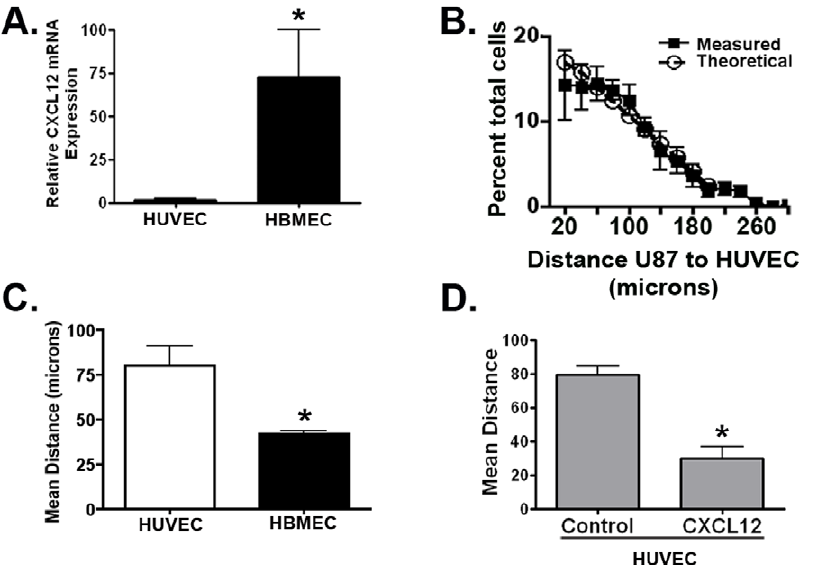
Figure 4. U87 localization to the peri-endothelial space is correlated with CXCL12 expression. ( A ) Quantitative PCR reveals that HUVECs express significantly lower levels of CXCL12 than HBMECs. N=3, **=p , 0.005 as determined by two-tailed t -test. ( B ) The distance between greater than 1000 eGFP-expressing U87 cells and mCherry fluorescent protein-expressing HUVECs in co-culture was measured and the distribution was plotted as the percentage of total cells in 20 micron increments (filled squares). Approximately 30% of the total U87 cells in the culture were within 40 microns of an endothelial cell (compare to Figure 3B ). This distribution does not differ from a theoretical plot of a random distribution of cells (open circles) ( C ) A statistically significant difference existed between the mean distance of U87 cells to HBMECs versus the mean difference between U87 and HUVECs. *=p , 0.05 as determined by two-tailed t -test for the means of four separate experiments involving approximately 330 measurements per endothelial co-culture per experiment. ( D ) When cultured with HUVECs that are engineered to over-express CXCL12, U87s show a similar co-localization pattern (as seen with HBMECs) consistent with a significant reduction in mean distance when compared to co-cultures with control HUVECs. *=p , 0.05 as determined by two-tailed t -test for the means of two separate experiments involving approximately 300 measurements per endothelial co-culture per experiment.